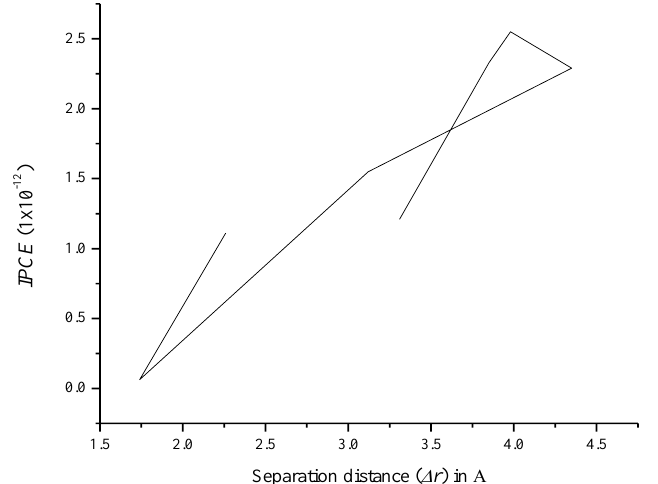
Figure 11. Graphical relationship between electron − hole separation distance and incident photon transfer efficiency.